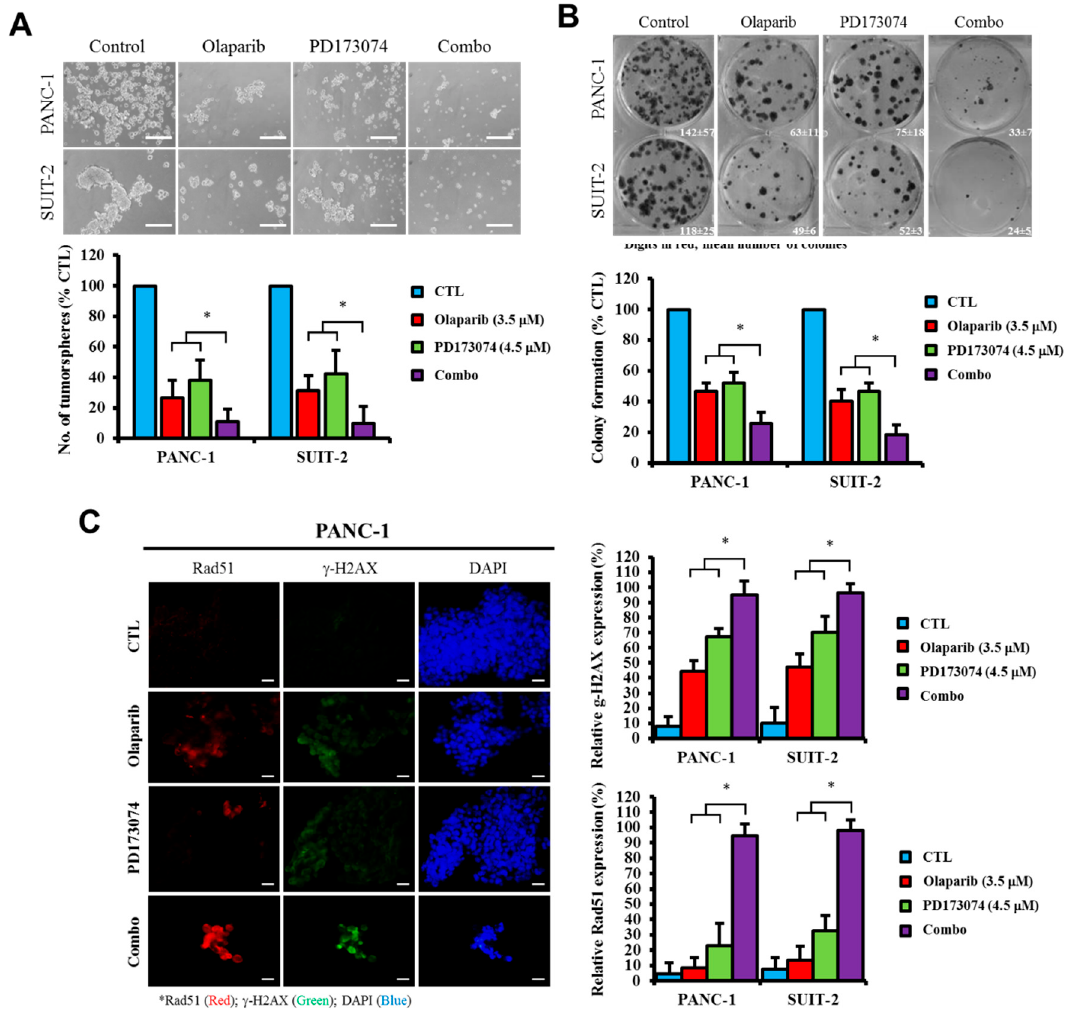
Figure 5. Olaparib alone or in synergism with PD173074 suppresses the oncogenic cancer stem cell-like phenotype of PDAC cells through an apoptosis-related impairment of DNA repair. ( A ) Tumorsphere formation assay images and histograms showing the e ff ect of PD173074 and / or olaparib on the tumorsphere formation e ffi ciency of the PANC-1 or SUIT-2 cells. ( B ) Representative colony formation assay data (left) and graph (right) showing the e ff ect of PD17374 and / or olaparib on the number of colonies formed by PANC-1 or SUIT-2 cells. ( C ) Immunofluorescence images and histograms of γ -H2AX (red), RAD51 (green), and nuclear DAPI (blue) staining in PANC-1 cells treated with PD173074 and / or olaparib compared with the control. Scale bar, 10 µ m. ( D ) Downregulation of FGFR1, Sox2, and Nanog protein expression levels in PD173074-treated Panc-1 cells as determined by Western blot analysis. β -actin was used as a loading control. * p <